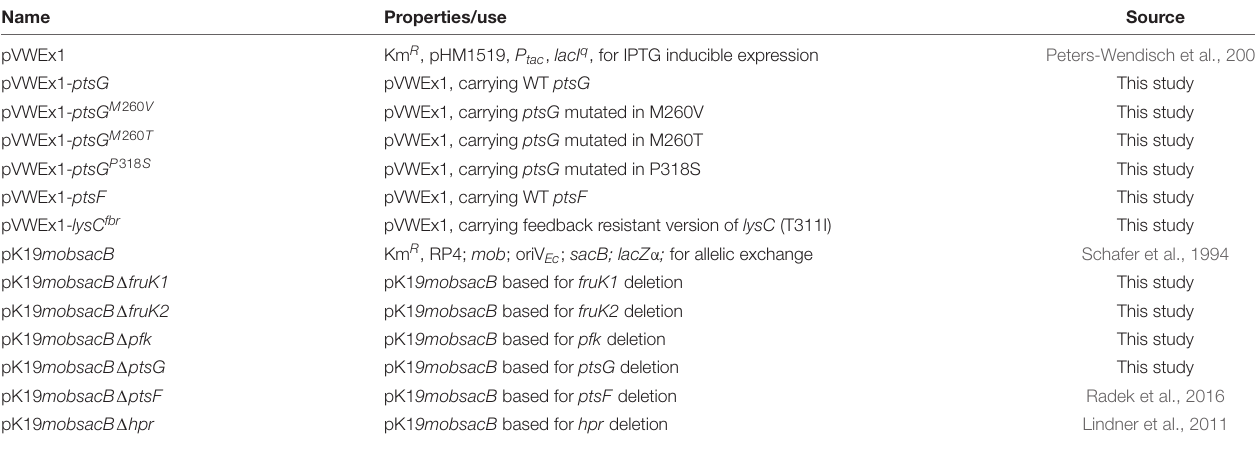
TABLE 2 | Plasmids used in this